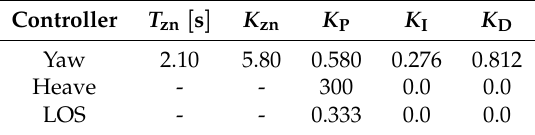
Table 5. PID parameters for